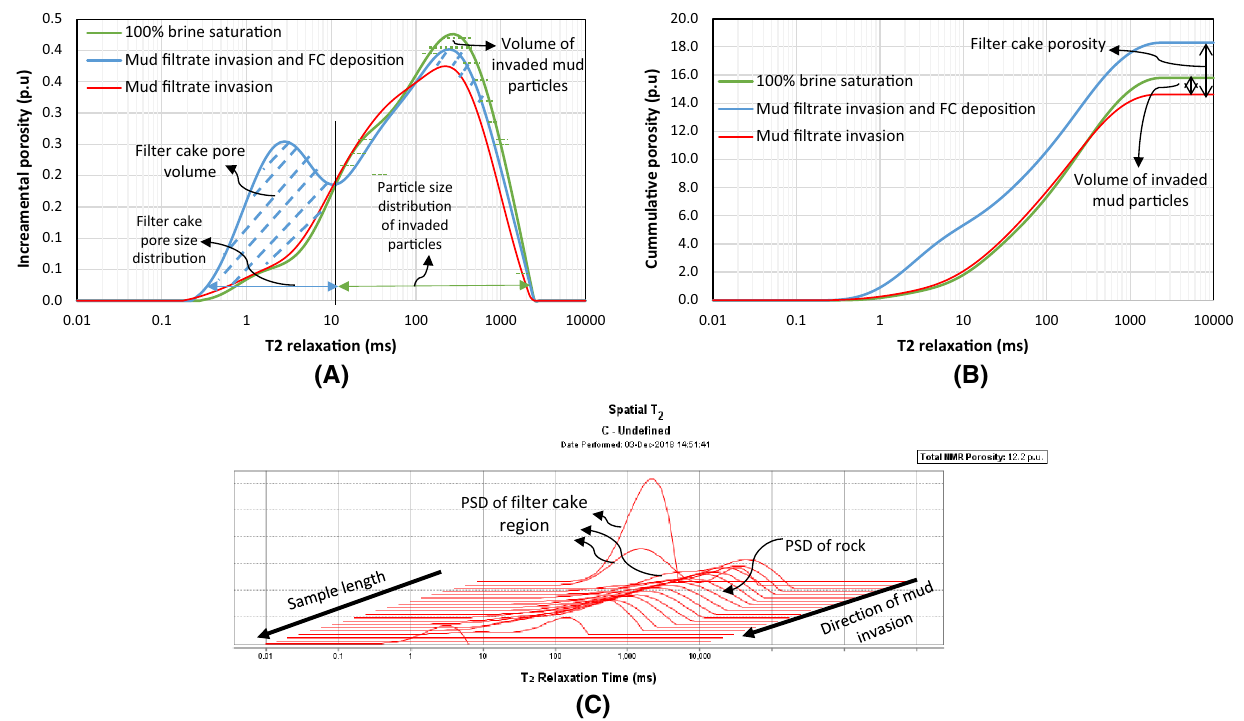
Fig. 9 Sample 3 ( A ) PDF of NMR T Corresponding cumulative pore sizes (porosity) for the different sam- 2 relaxation showing the pore ple states. C Spatial pore size distribution along the sample size distribution at 100% KCl saturation (green), after mud invasion and filter cake deposition (blue), and after removal of filter cake. B